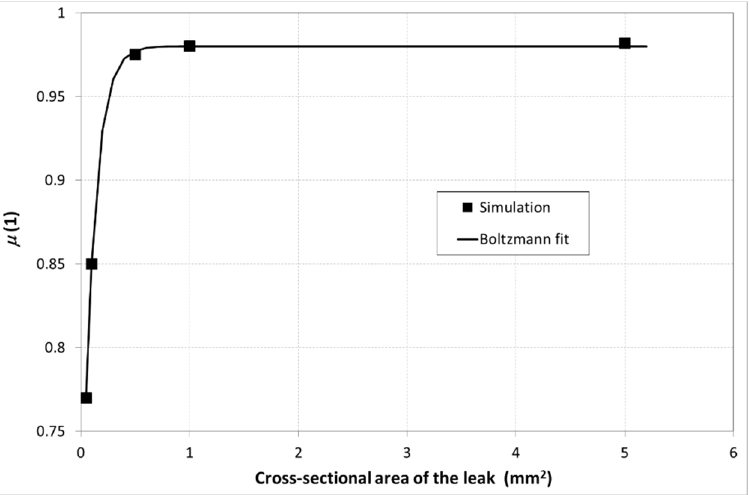
Figure 7. Curve of the correlation between the efflux coefficient and the cross-sectional area of the